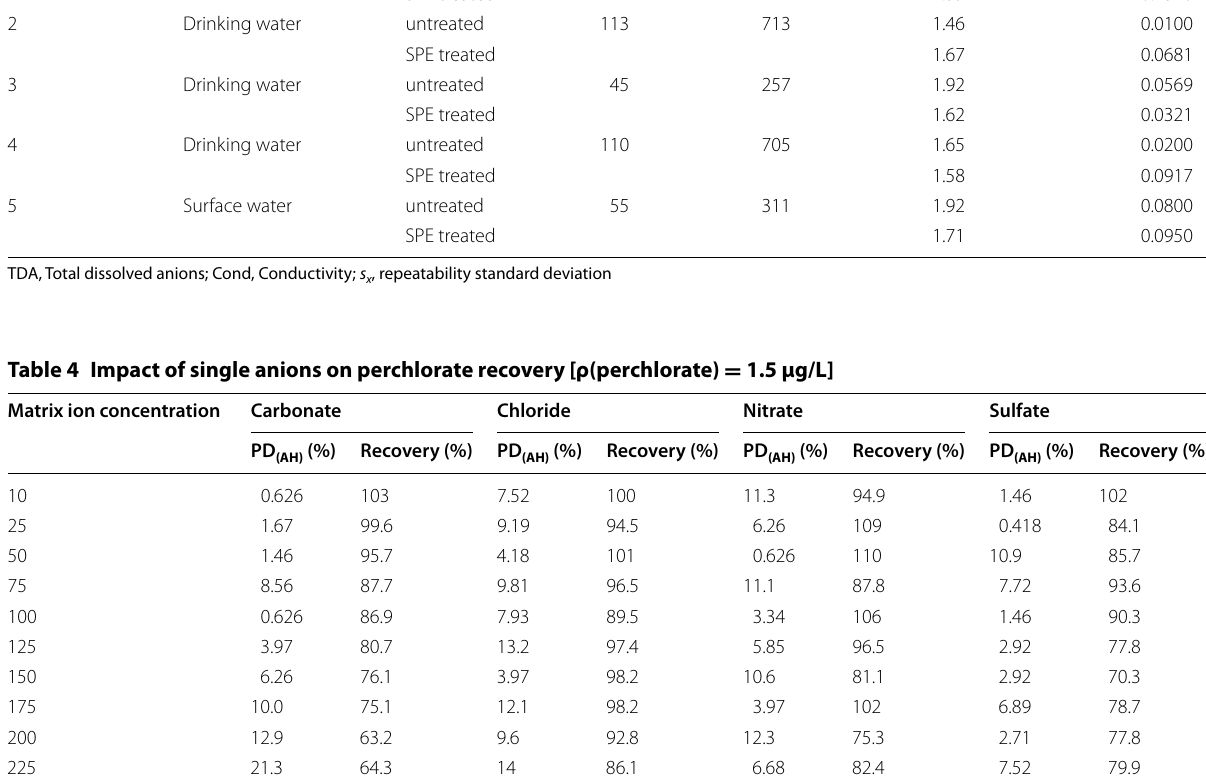
Table 3 Data for the verification of the perchlorate RL of 1.5 µg/L (average of three replicates) Sample